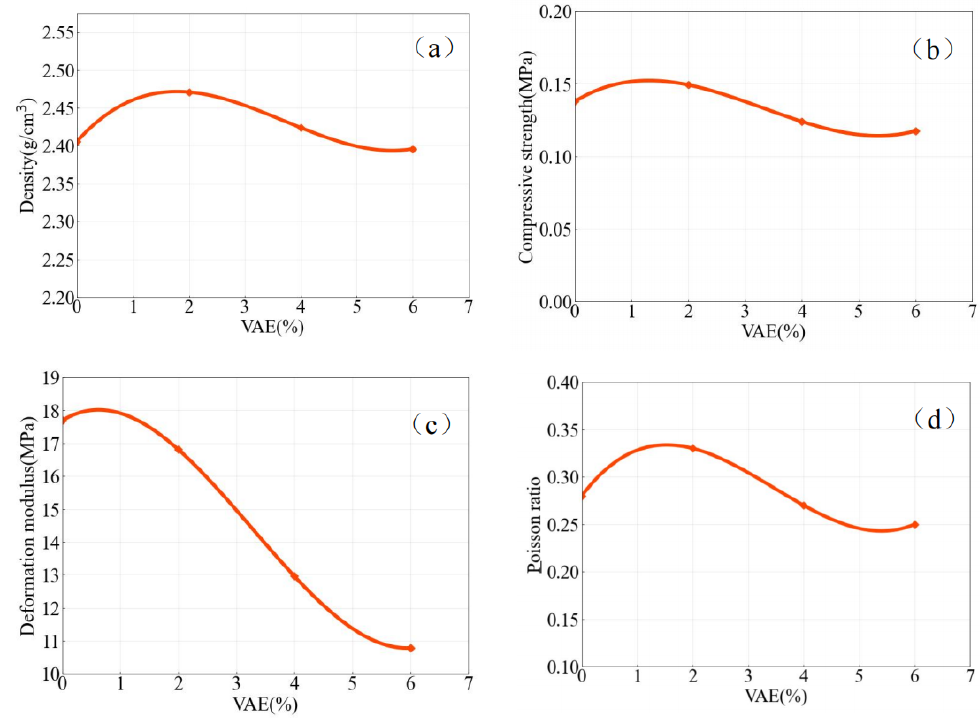
Figure 9. Relationship between VAE and indexes with different dosage. ( a ) Density. ( b ) Compressive strength. ( c ) Deformation modulus. ( d ) Poisson ratio.